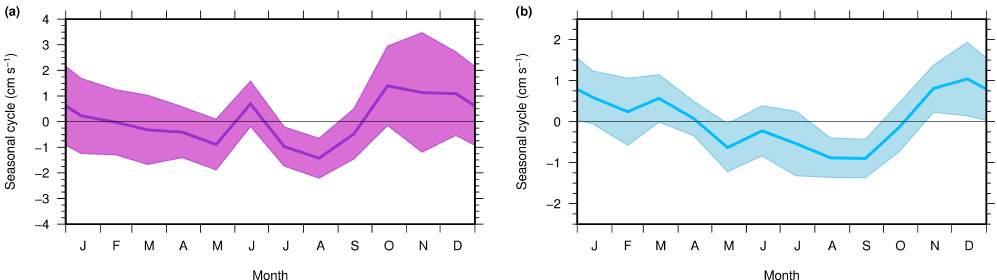
Figure 6. The seasonal cycle in the geostrophic currents (a) normal to the southeastern Beaufort Sea gate (positive southeasterly) and (b) the north–south geostrophic currents through Fram Strait (positive south). The annual mean current is removed from each year of data and we estimate the monthly mean and standard deviation (shown by the shaded band) of the resulting seasonal anomalies. The colour corresponds to the gate colour shown in Fig. 4.